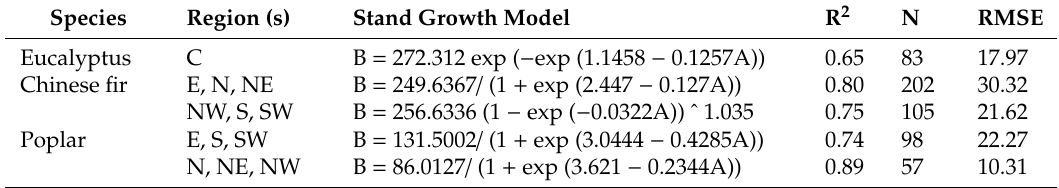
Table 1. Stand growth models to estimate the change of forest biomass carbon with stand age. Species Region (s) Stand Growth Model